Question: What type of chart is this?
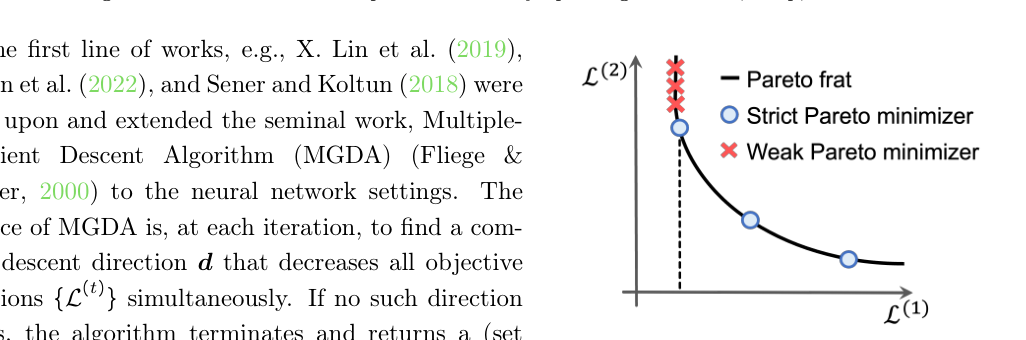
Answer: line